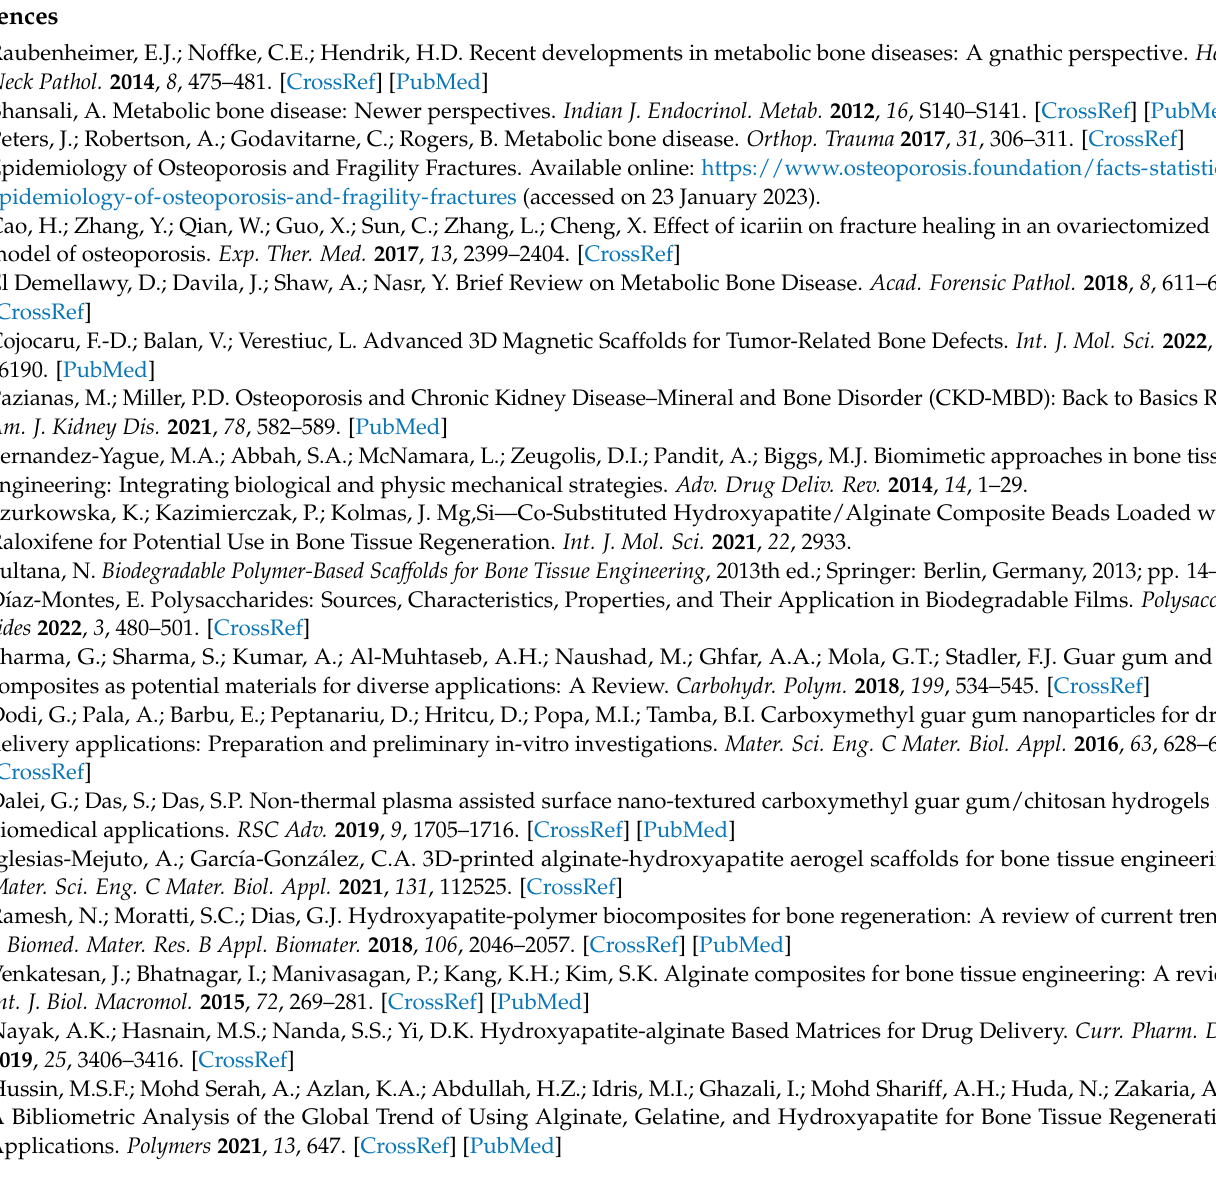
Figure A8. The results of the mechanical assay, displayed by the device used (TA-XT2 Plus) for the HA used in the preparation of the beads .